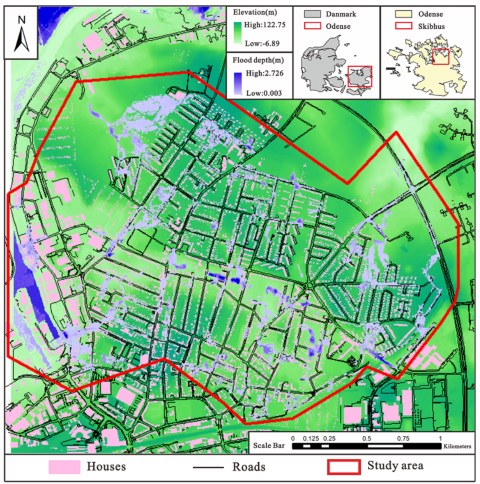
Figure 2. Descriptions of the urban land use, topography and flood-prone areas of the study